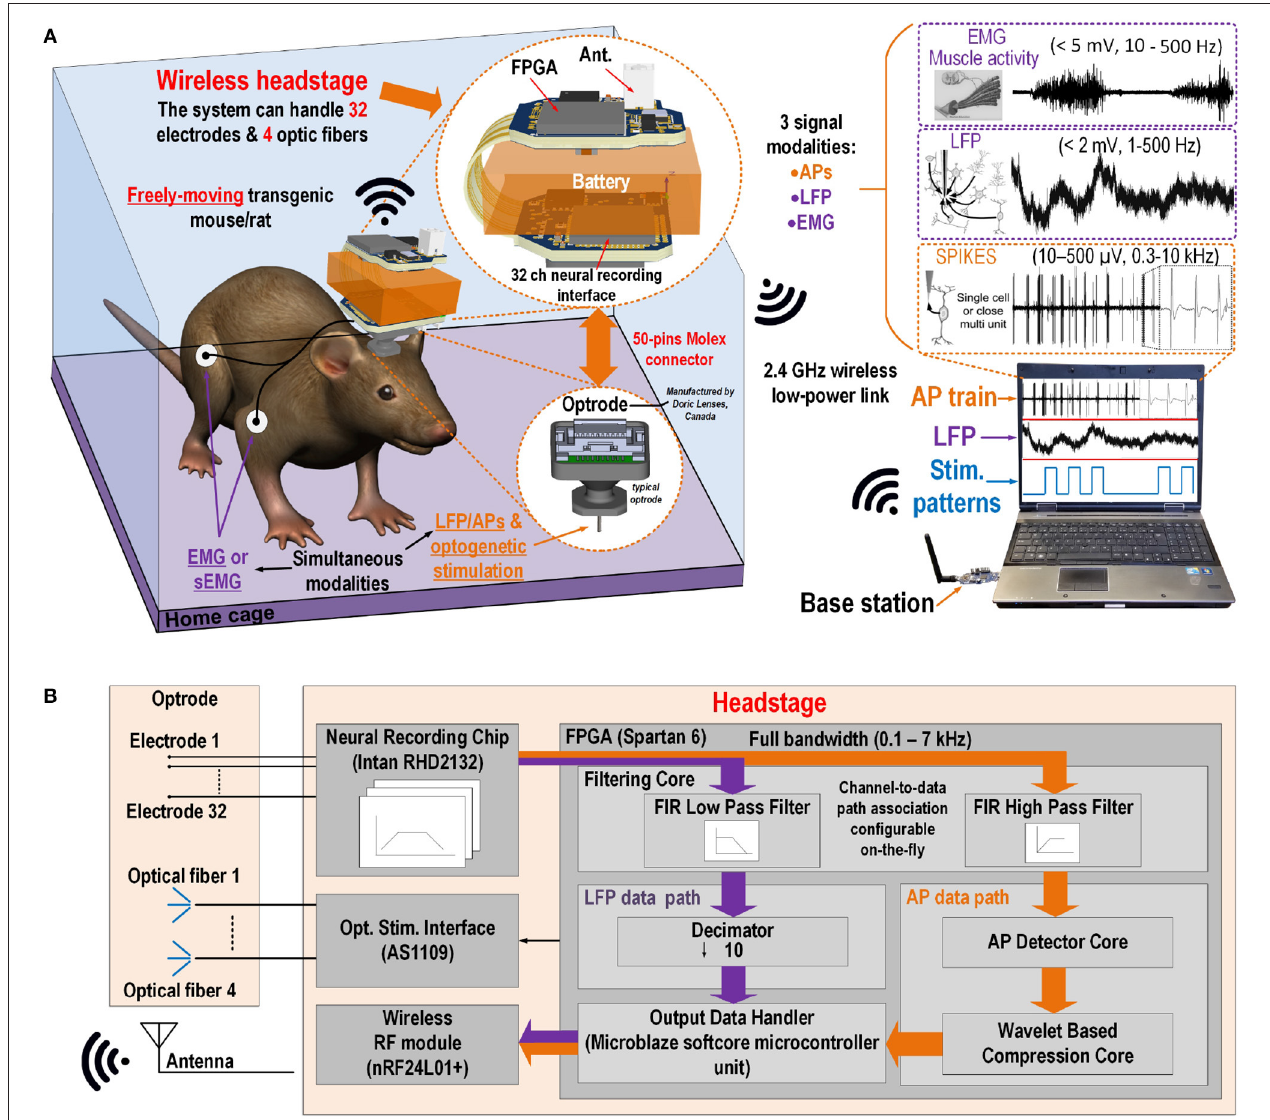
FIGURE 1 | (A) On the left, the concept of the platform connected on an optrode secured on the head of a rodent and to EMG electrodes going to its arm. On the right, the base station with the computer host communicating with the platform. (B) System level concept of the